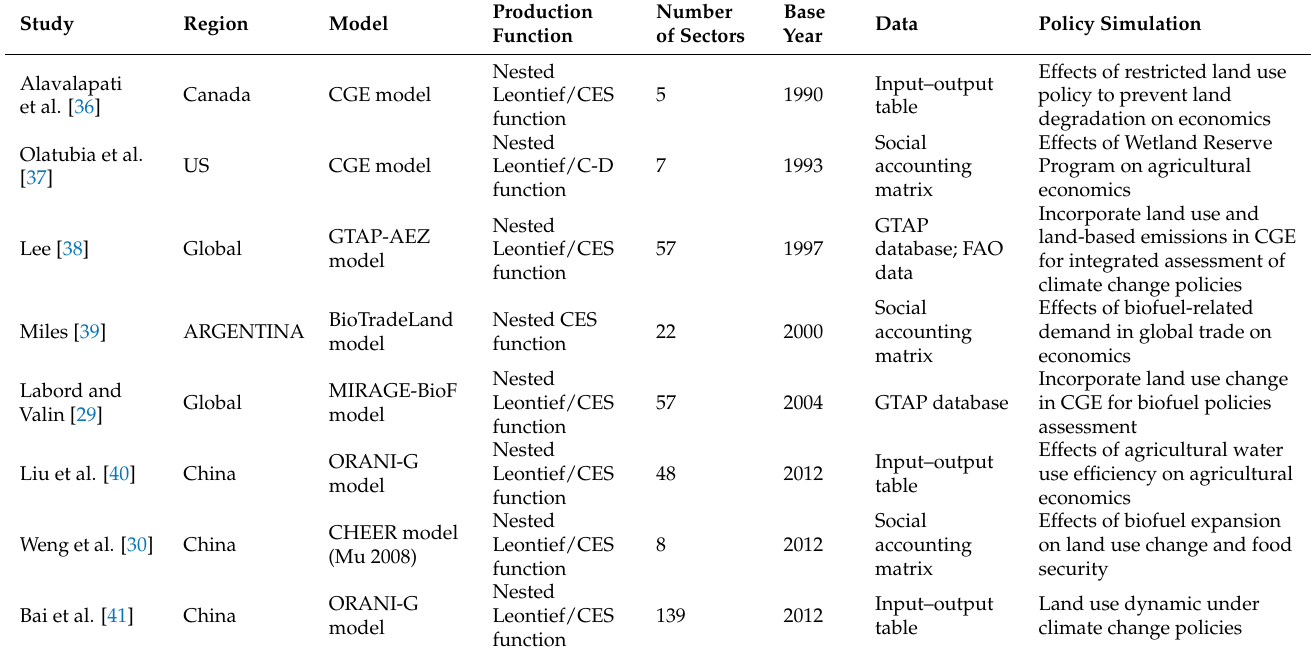
Table 1. CGE models related to land use